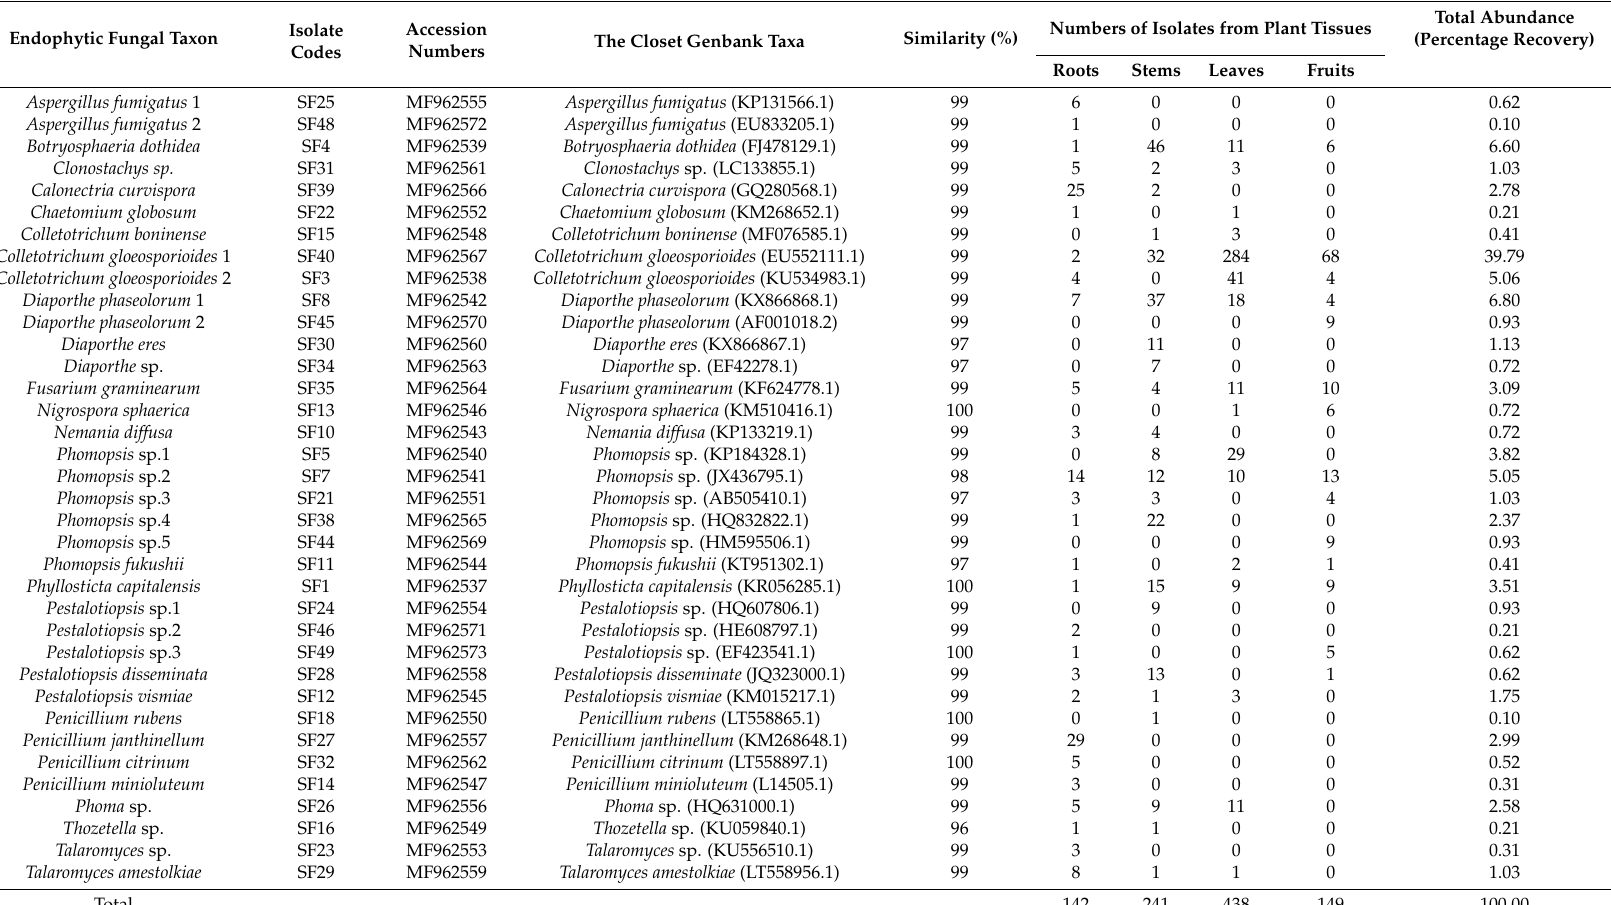
Table 1. Identification, abundance, and percentage recovery of endophytic fungi isolated from different tissues of Litsea cubeba (Lour.)